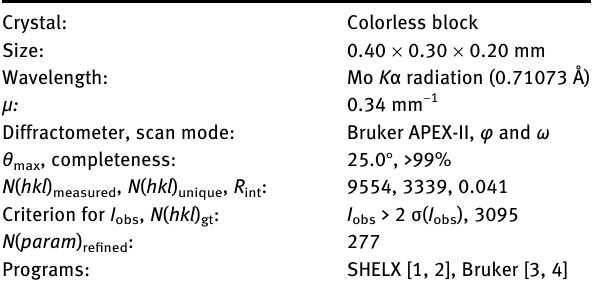
Table 2 contains the list of the atoms including atomic co- ordinates and displacement parameters.